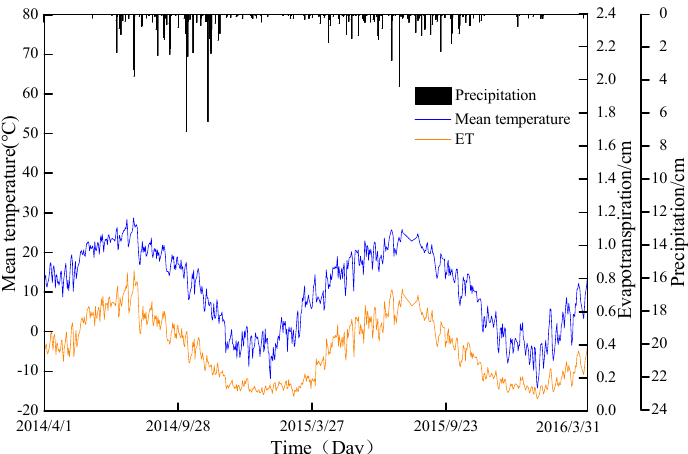
Figure 2. Daily precipitation, evapotranspiration, and mean temperature observed at the Ji county weather station from 1 April 2014, to 31 March 2016.